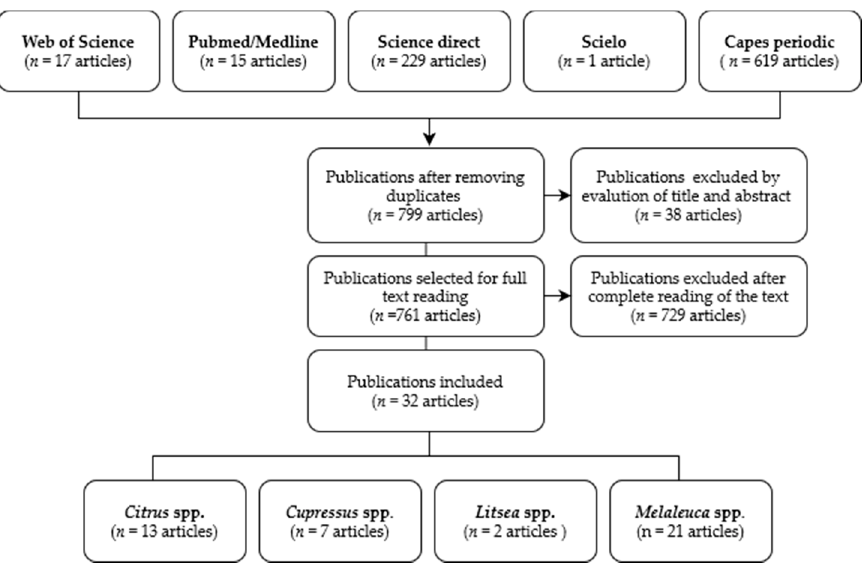
Figure 1. Flow diagram of retrieved, selected, included, and excluded